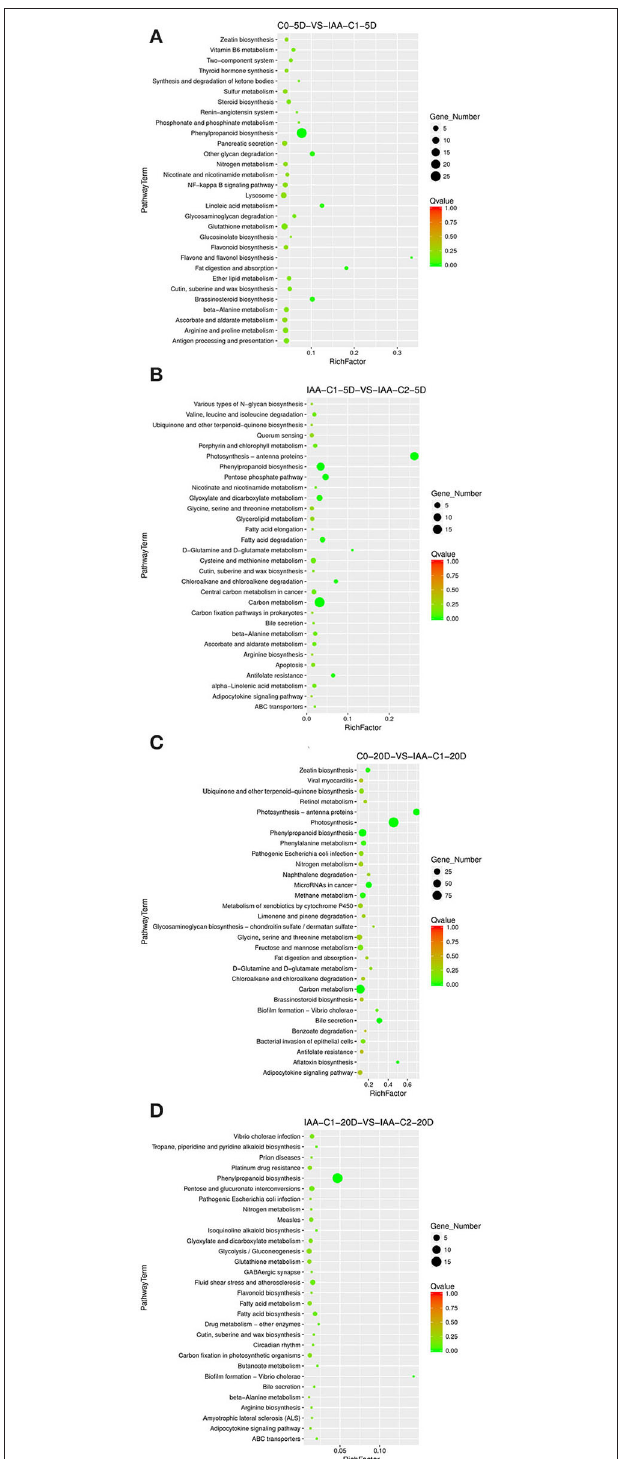
FIGURE 5 | The KEGG enrichment of DEGs in comparison groups under the IAA dose effect. (A) Pathways enriched in C0-5D vs. IAA-C1-5D; (B) Pathways enriched in IAA-C1-5D vs. IAA-C2-5D; (C) Pathways enriched in C0-20D vs. IAA-C1-20D; and (D) Pathways enriched in IAA-C1-20D vs. IAA-C2-20D. IAA, indole acetic acid; 24D, 2,4-dichlorophenoxyacetic acid; C0, 0mg L − 1 ; C1, 0.025mg L − 1 ; C2, 0.05mg L − 1 ; 5D, 5 days’ treatment; 20D, 20 days’